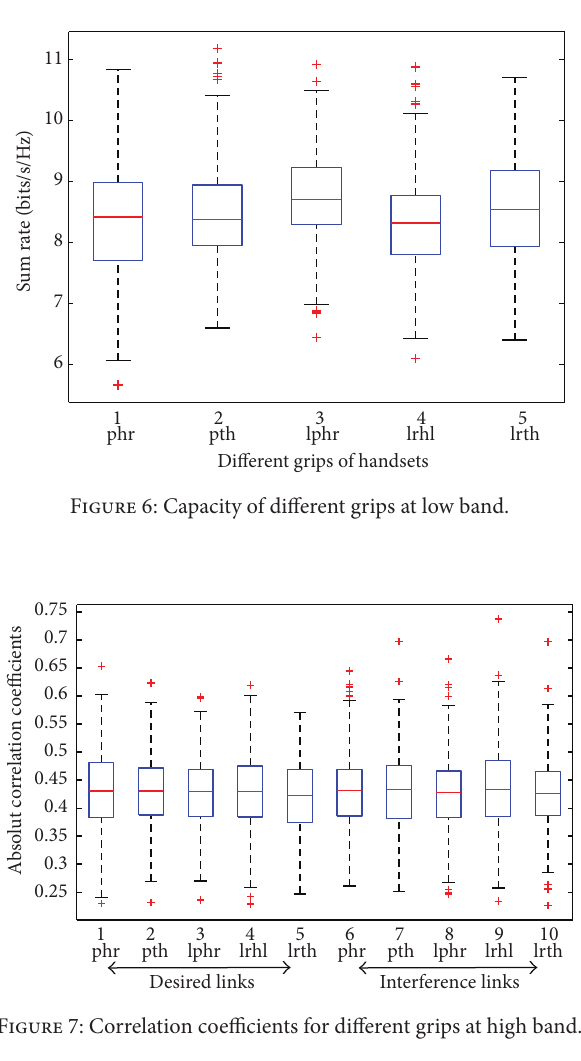
each antenna at the user towards each antenna at each BS.